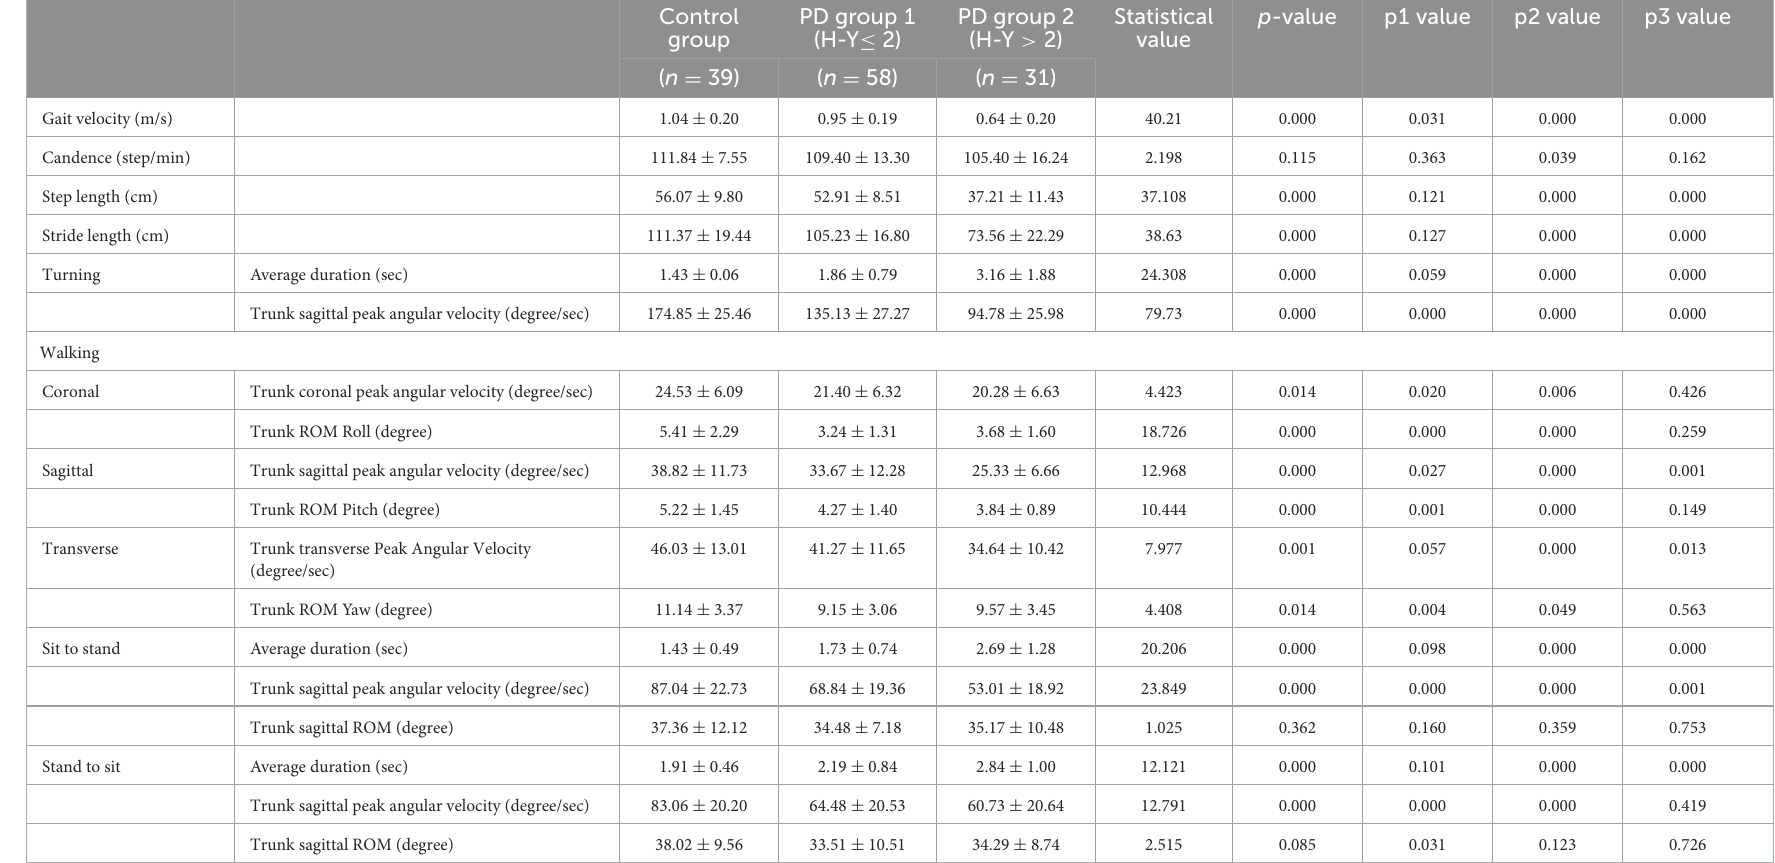
TABLE 2 Kinematic parameters of two PD groups and control